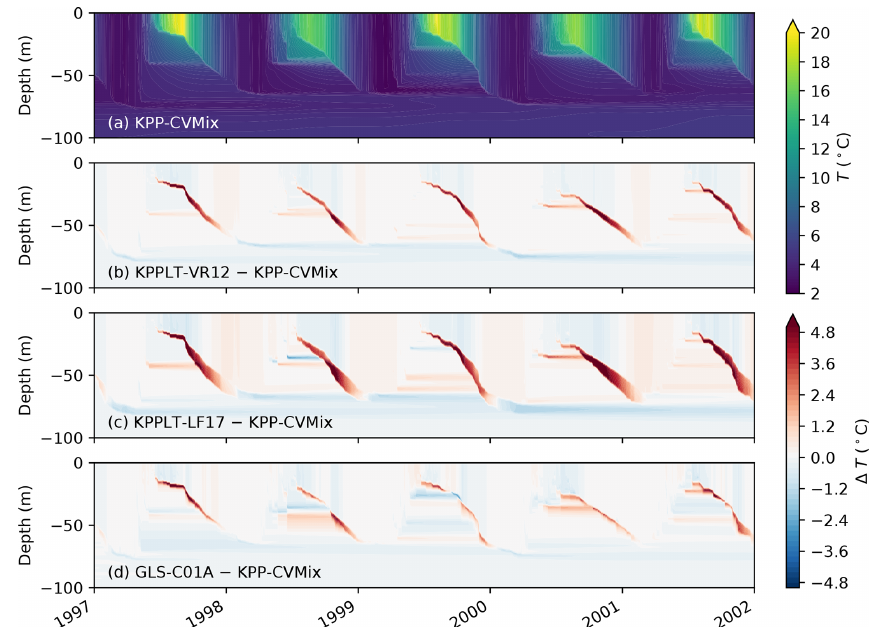
Figure 13. Hovmöller diagrams comparing the simulated temperature between the four vertical mixing schemes at the Gotland Basin. Panel (a) shows the simulated temperature in KPP-CVMix. Panels (b) – (d) show the differences from KPP-CVMix in KPPLT-VR12, KPPLT- LF17, and